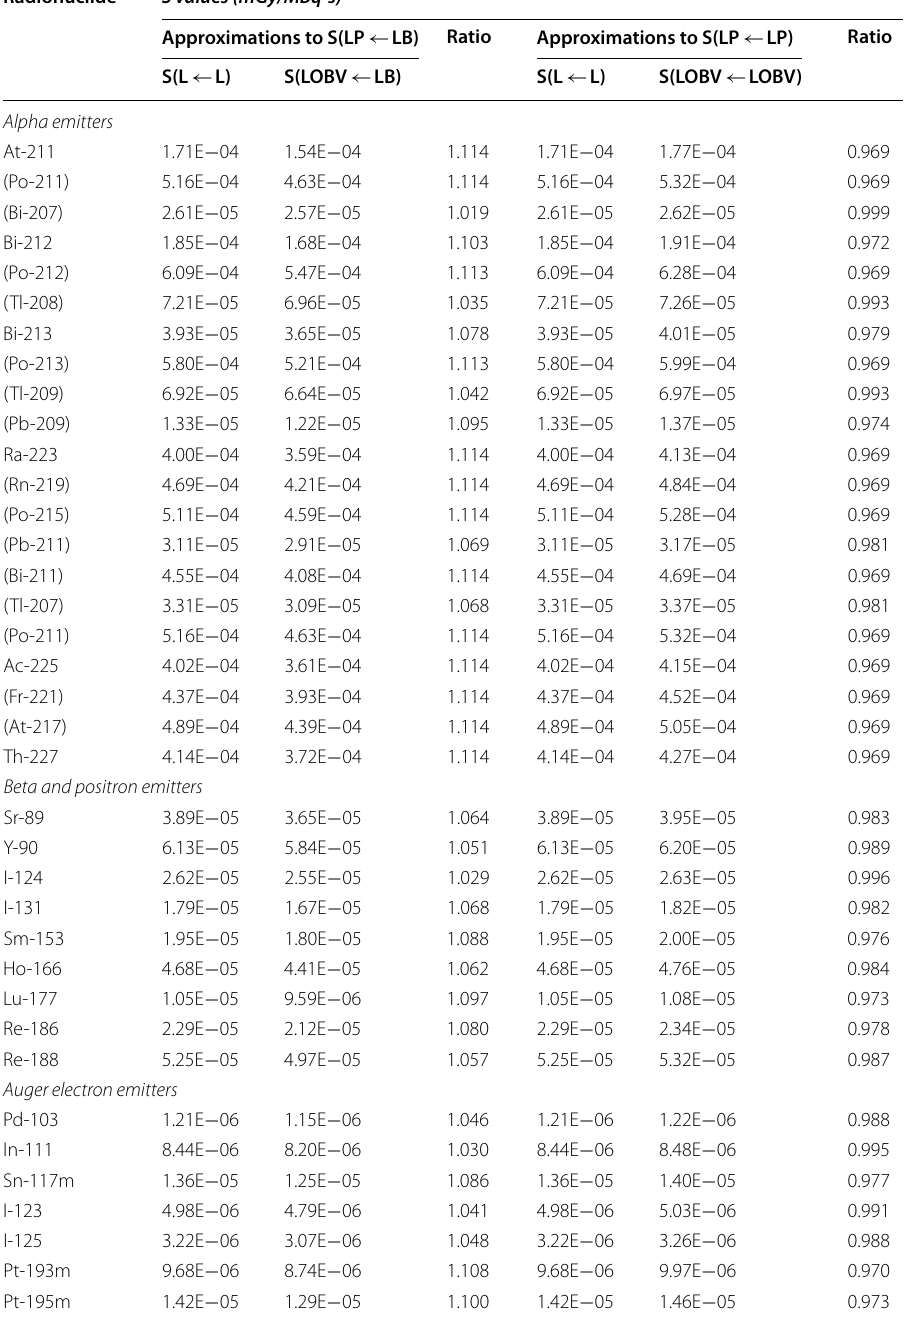
Table 6 Approximations of S ( LP ← LB ) and S ( LP ← LP ) values for 22 radionuclides (and 14 additional alpha‑emitter decay progeny) with applications to radiopharmaceutical therapy using the single‑ region and dual‑region tetrahedral mesh models of the reference adult male liver